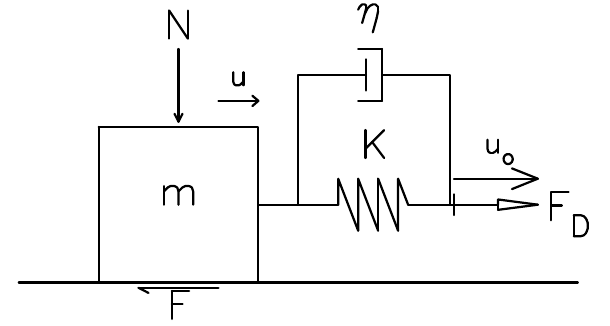
Figure 1. One-body spring-slider model. In the figure, u , K , η , F D , N , and F denote, respectively, the displacement, the spring con- stant, the viscosity coefficient, the driving force, the normal force, and the frictional force.